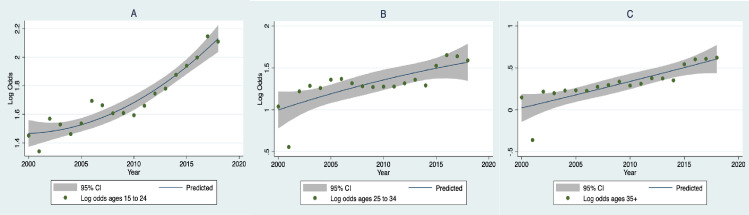
Plots and best fitting trends between study year and the log odds of homicides attributable to firearms for (A) ages 15 to 24, (B) ages 25 to 34, and (C) ages 35+.